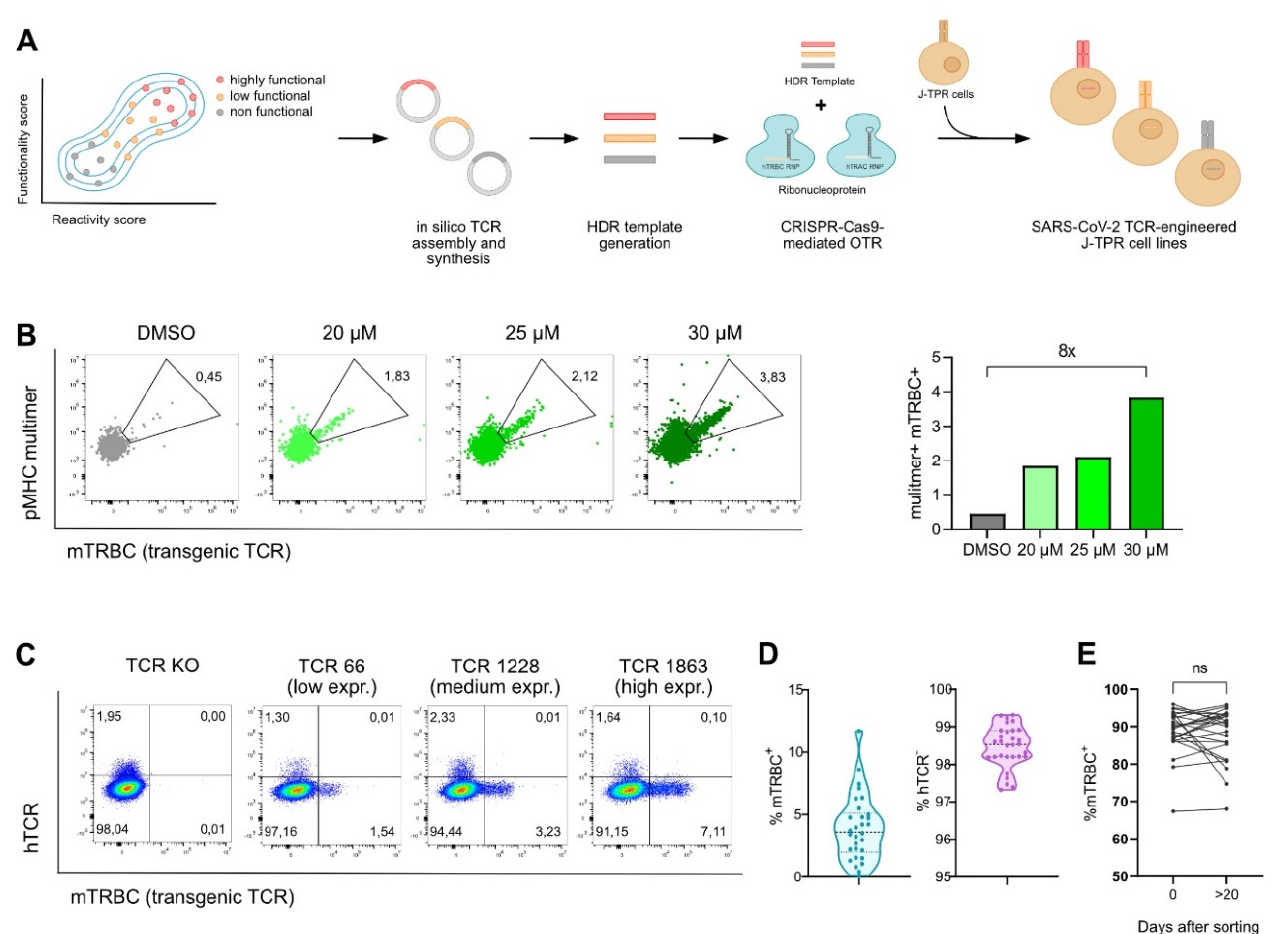
Figure 1. Generation of SARS-CoV-2 TCR-engineered J-TPR-CD8 + cells. ( A ) Schematic workflow describing the generation of SARS-CoV-2 TCR-engineered J-TPR-CD8 + cells. TCRs were selected based on their functionality and reactivity scores. Transgenic TCRs were in silico assembled, synthesized, and cloned into a vector. DNA templates were generated via PCR and eventually delivered into J-TPR-CD8 + cells together with TRAC and TRBC ribonucleoproteins (RNPs) for TCR replacement. ( B ) J-TPR-CD8 + cells were processed for CRISPR-Cas9 OTR as described in (A). HDR enhancer was added to the cell culture after electroporation for 18 h at the indicated concentrations. Shown are flow cytometry blots (left) and quantification (right) of multimer + mTRBC + cells (pregated on living lymphocytes). ( C ) Exemplary flow cytometry blots showing the endogenous TCR KO (hTCR - ) and the transgenic TCR KI (mTRBC + ) on day 4 post genome editing. Depicted are examples of low, medium, and high KI efficiencies. ( D ) Summary of the frequencies of mTRBC KI and hTCR KO of all SARS-CoV-2-specific TCRs 4 days post CRISPR-Cas9 editing depicted as violin plot. The mean is shown as wide dashed line and the quartiles are shown as tight dashed lines. ( E ) mTRBC expression on day 0 and day >20 after flow cytometry-based cell sorting. Data points per TCR are connected by a line. Statistical analysis was performed with a paired t -test. ns, p > 0.05.